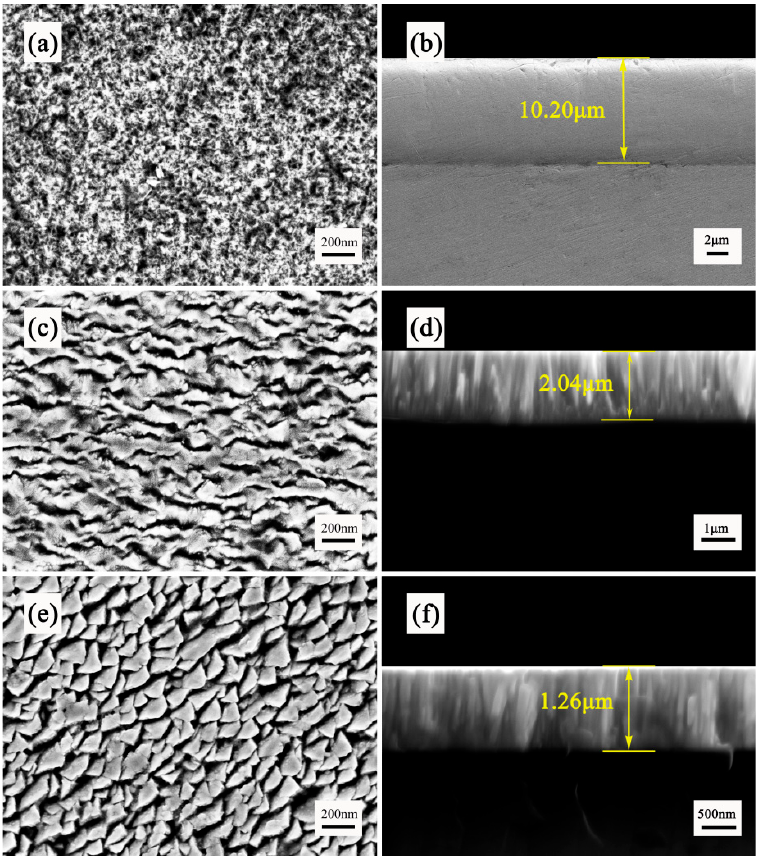
Figure 4. SEM micrographs of surface and cross-section of Cr coatings deposited under ( a , b ) EPHC; ( c , d ) MSIP; ( e , f ) MAIP.